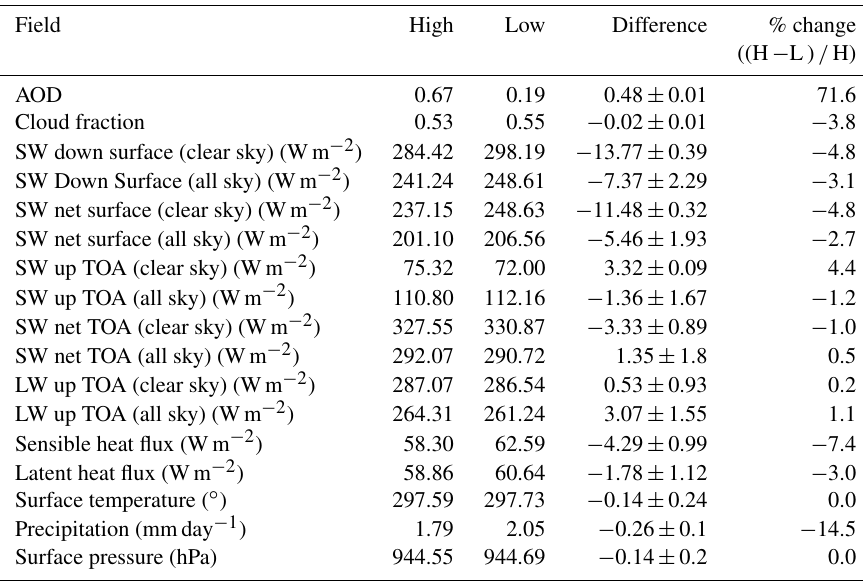
Figure 4. Optical properties used in the standard CLASSIC configuration for BBA at visible wavelengths (black: fresh BBA; red: aged BBA) and the new representations applied in this work for fresh and aged BBA (green dashed line). (a) Mass scattering coefficient; (b) mass absorption coefficient; (c) mass extinction coefficient; (d) single scattering albedo. AERONET SSA at 550nm is also shown (purple) with horizontal lines indicating long-term maximum, mean and minimum (see text for details). Table 1. Table of September mean values for the high and low experiments and the differences between them. The percentage changes in the table are calculated as (high − low) / high. The means are calculated over the biomass burning box (latitude 5–25 ◦ S, longitude 40–70 ◦ W), which is outlined in Fig.